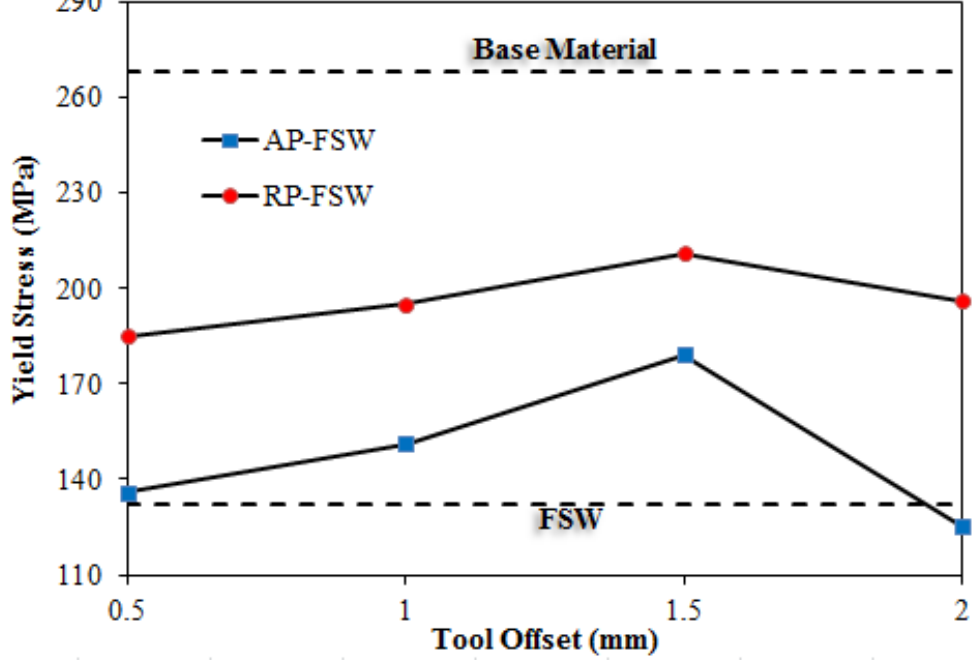
Figure 8. Comparison of YS values of welded specimens with FSW, AP-FSW, and RP-FSW tech- niques.